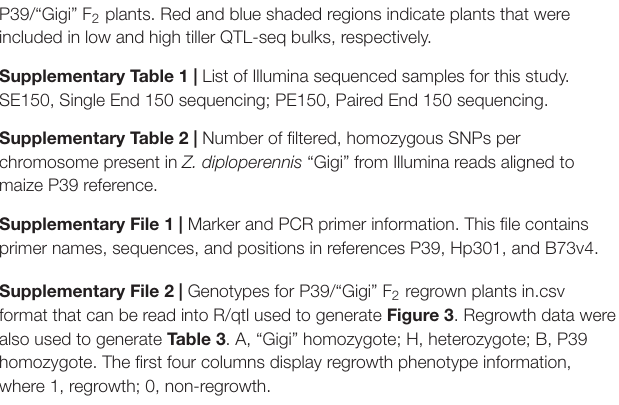
Supplementary Figure 2 | Distribution of tiller number phenotype in field-grown P39/“Gigi” F 2 plants. Red and blue shaded regions indicate plants that were included in low and high tiller QTL-seq bulks, respectively. Supplementary Table 1 | List of Illumina sequenced samples for this study. SE150, Single End 150 sequencing; PE150, Paired End 150 sequencing. Supplementary Table 2 | Number of filtered, homozygous SNPs per chromosome present in Z. diploperennis “Gigi” from Illumina reads aligned to maize P39